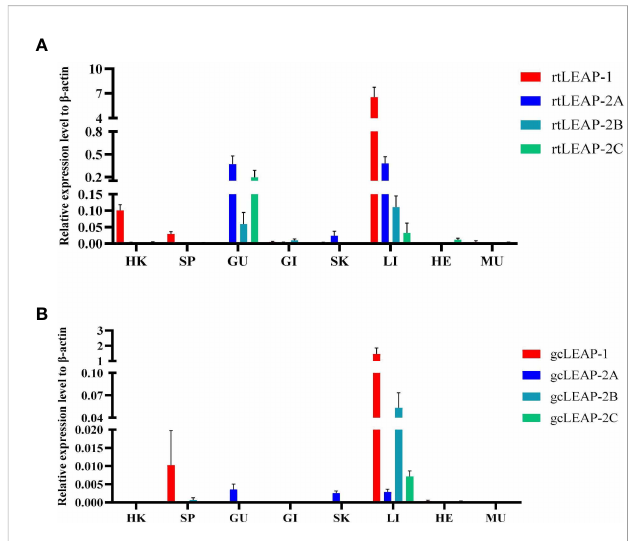
FIGURE 3 Expression patterns of rainbow trout (A) and grass carp (B) LEAPs in various tissues. The expression levels of LEAPs in lymphoid and non- lymphoid tissues were analyzed by qPCR and normalized against the expression of b -actin using the 2 − D Ct method. Abbreviations for tissues are as follows: HK, head kidney; SP, spleen; GU, gut; GI, gill; SK, skin; LI, liver; HE, heart; MU, muscle. Data for rainbow trout represent the mean ± SEM of four individuals, and data for grass carp represent the mean ± SEM of fi ve individuals.